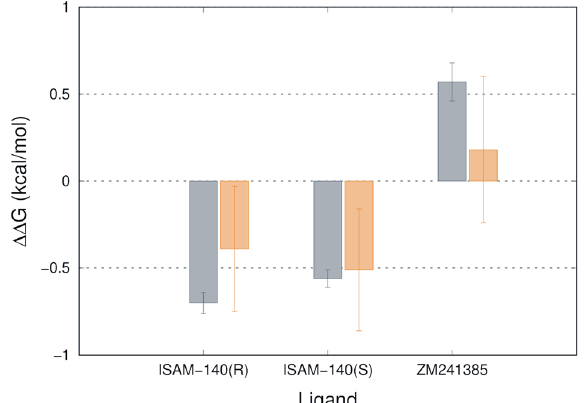
Figure 5. Experimental (grey) and calculated (orange) relative changes in binding free energies to the L249V 6.51 mutant A 2A AR for the two enantiomers of ISAM-140 and